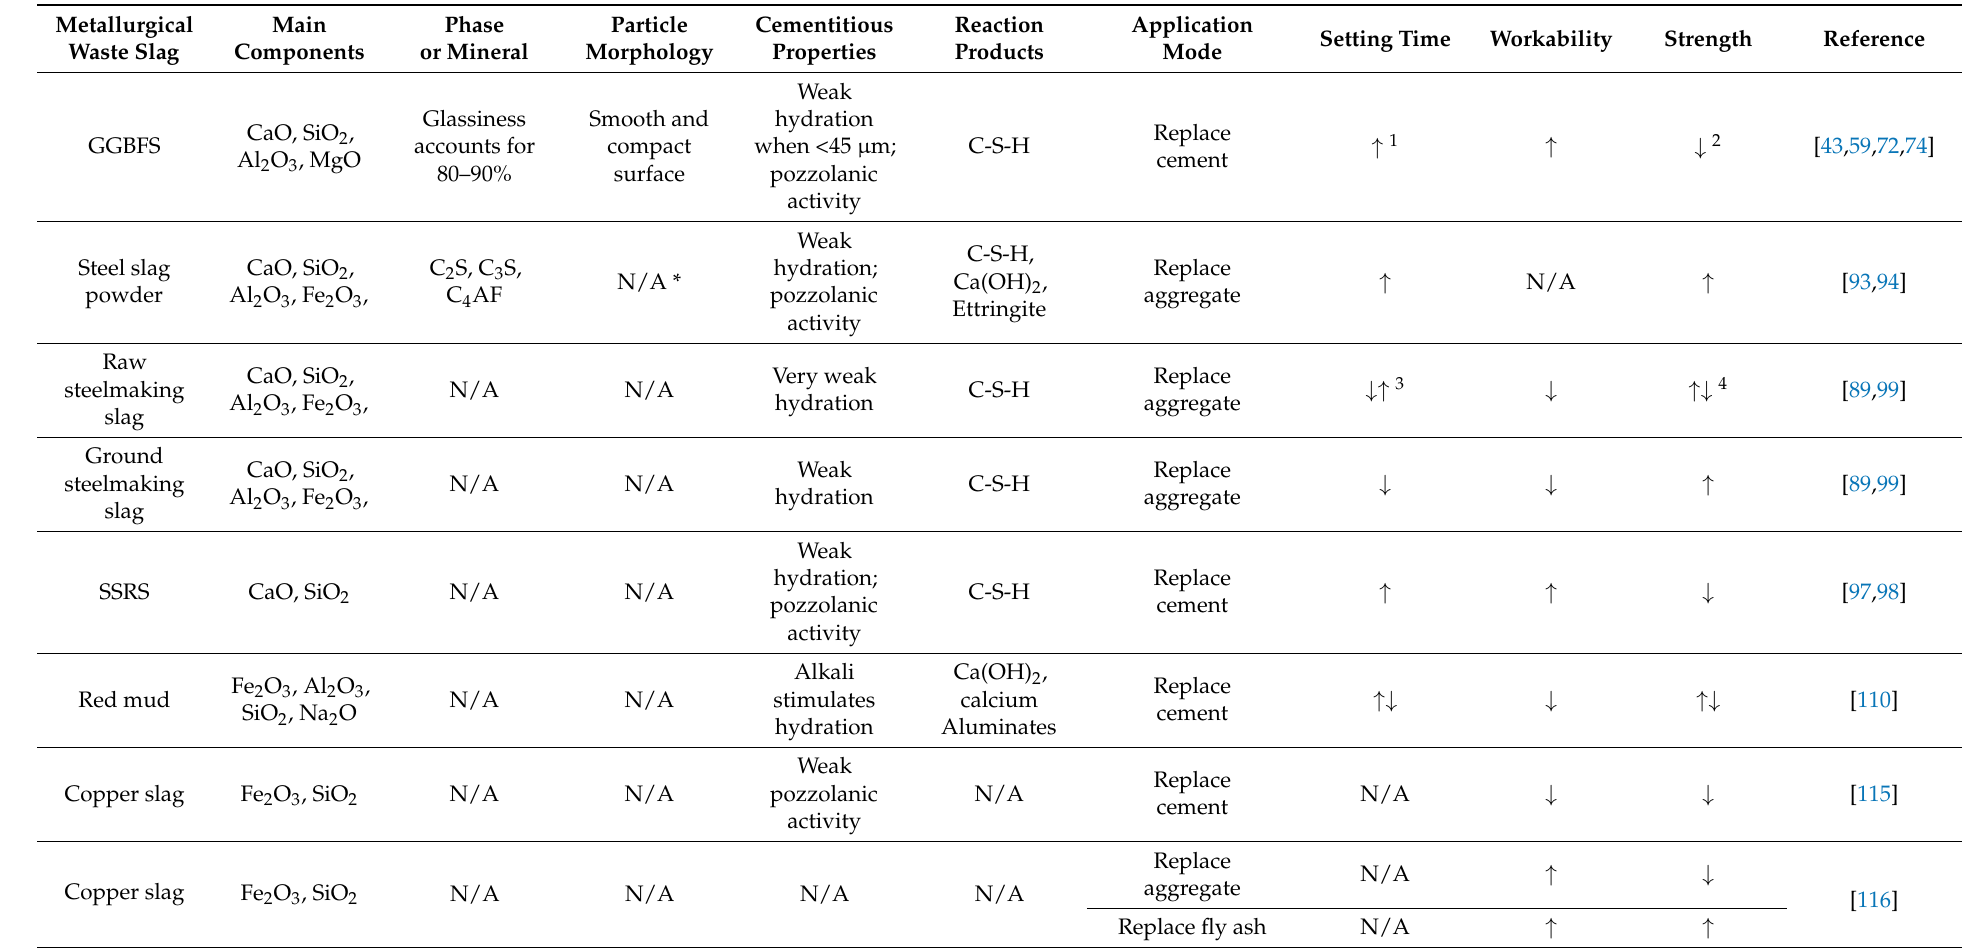
Table 3. Effects of metallurgical waste slags on CLSM